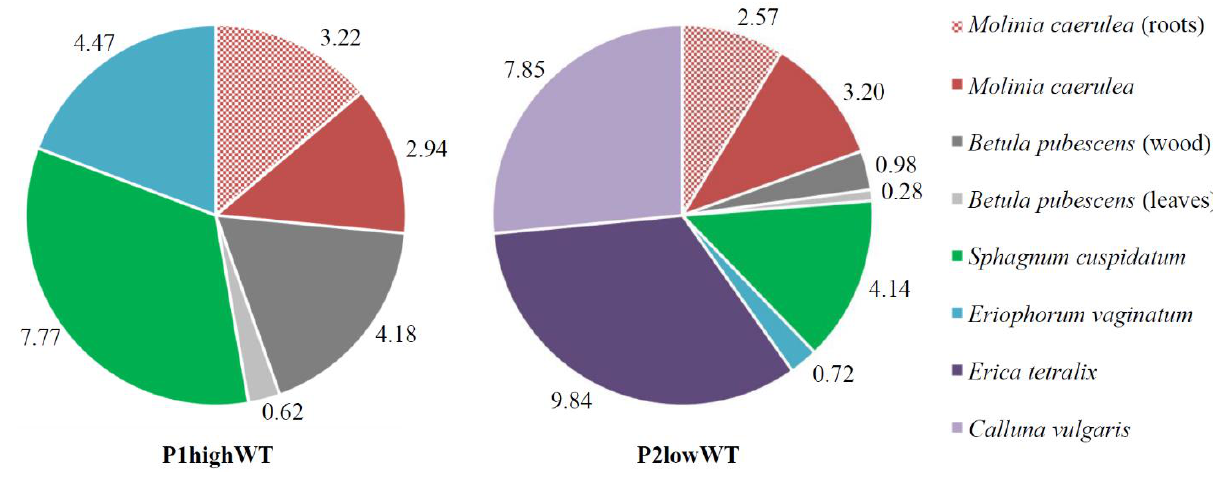
Figure 8. Total N storage (kg ha -1 ) of plant species (shoots of plants unless otherwise